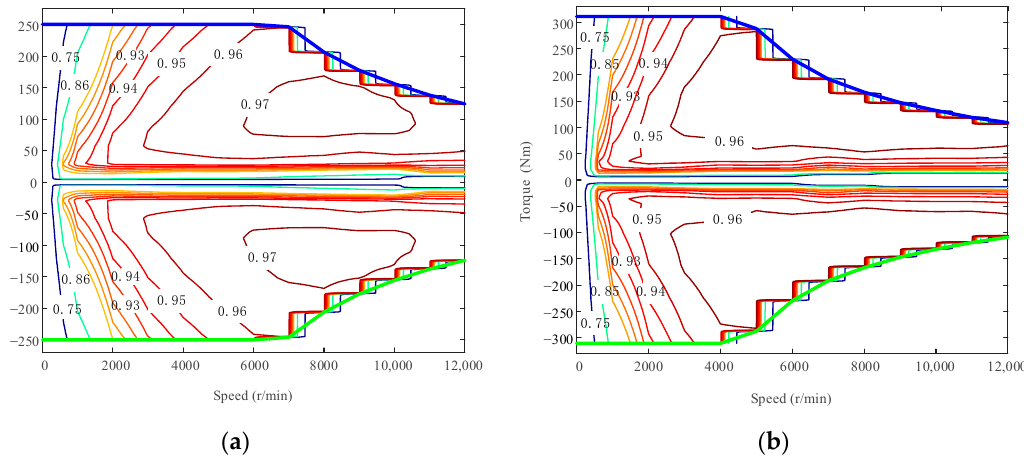
Figure 3. Efficiency maps of front motor ( a ) and rear motor ( b ).